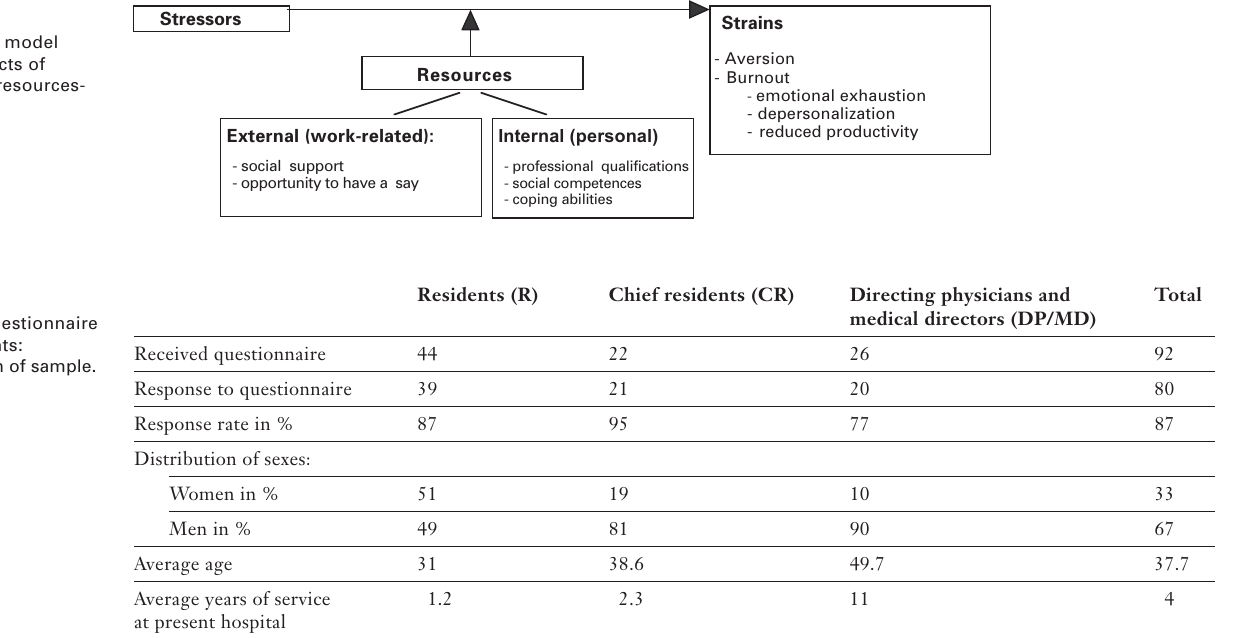
Simplified model of the effects of stressors-resources-